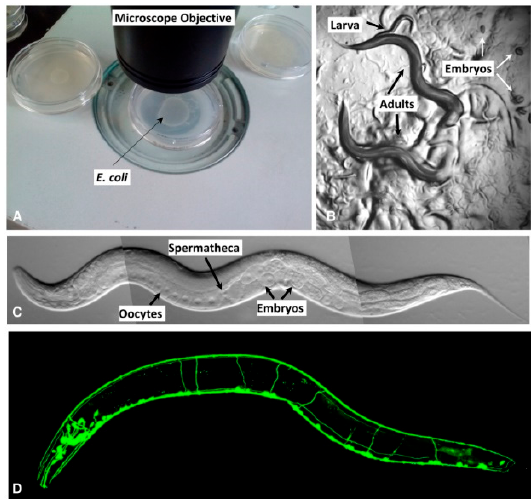
Figure 1. Different views of C. elegans in the laboratory. ( A ) Petri dishes with bacterial lawns on the surface of the agar (not visible in this picture). ( B ) Two adults move under a dissecting microscope. ( C ) View from a compound microscope of an adult hermaphrodite. ( D ) The nervous system is shown in the fluorescent image. Photo reprinted with permission of the Genetics Society of America